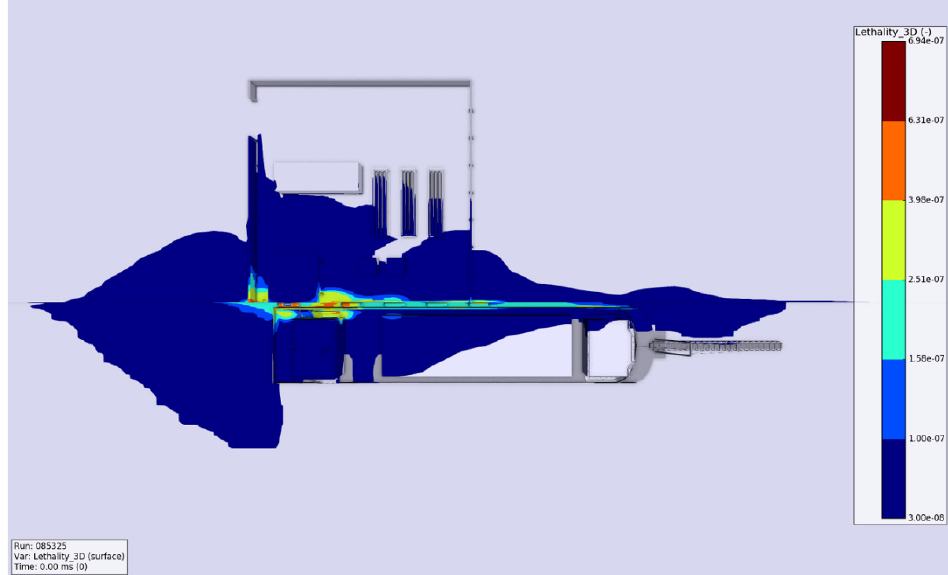
Figure 7. The individual risk varying with distance from the risk source.